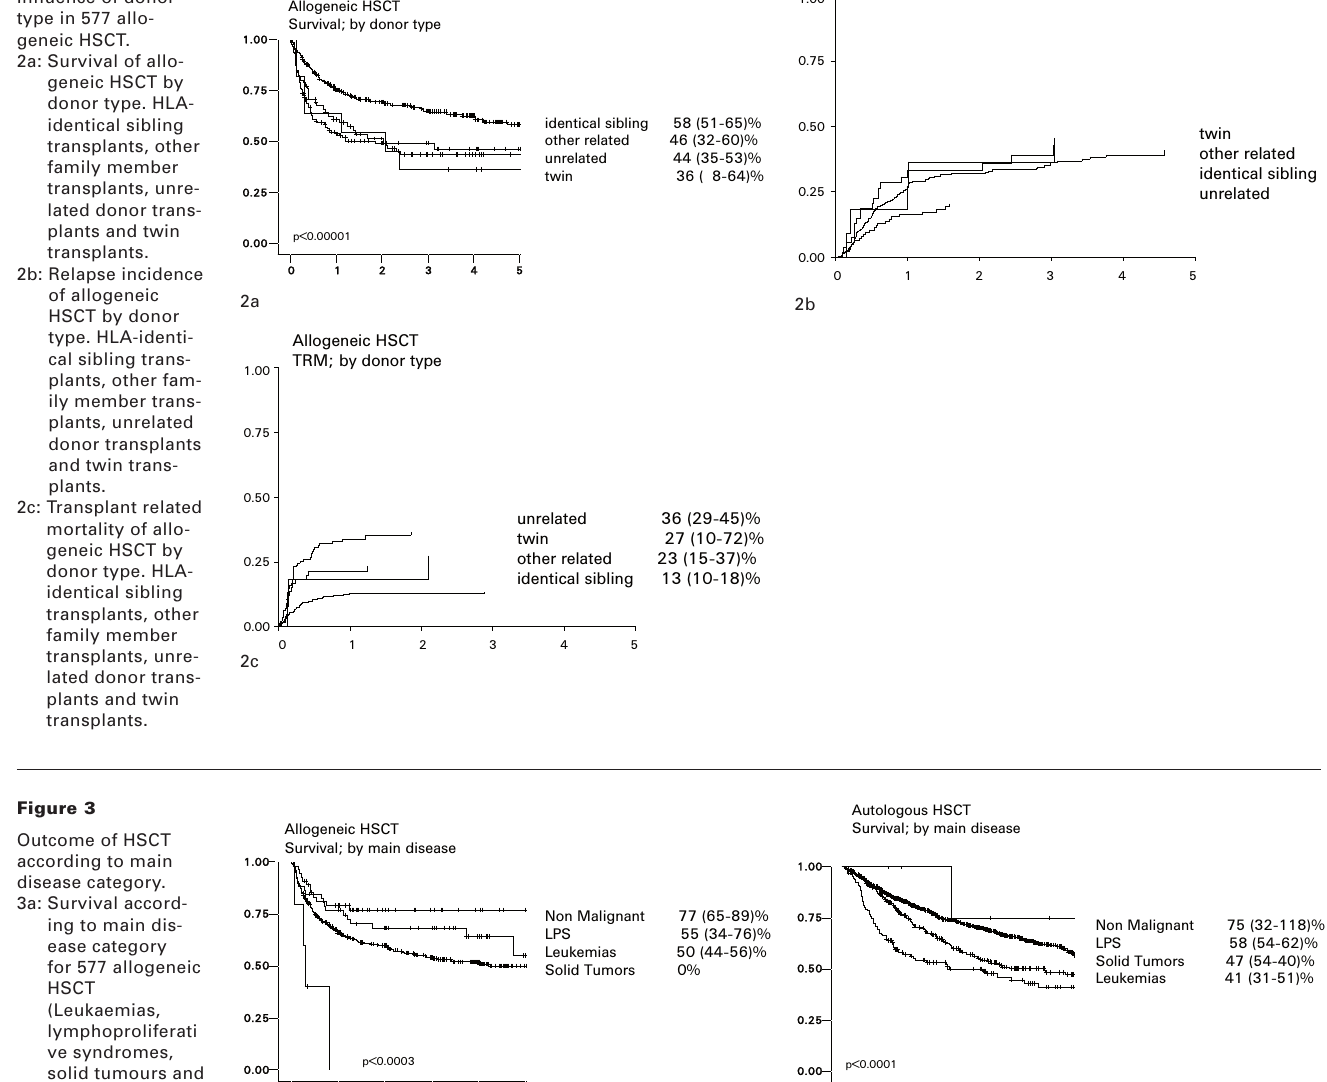
Figure 3 Outcome of HSCT according to main disease category. 3a: Survival accord- ing to main dis- ease category for 577 allogeneic HSCT (Leukaemias, lymphoproliferati ve syndromes, solid tumours and non malignant disorders). 3b: Survival accord- ing to main dis- ease category for 1433 autologous HSCT(Leukaemia, lymphoprolifera- tive syndromes, solid tumours and non malig- nant disorders). LPS = lympho- proliferative syndromes